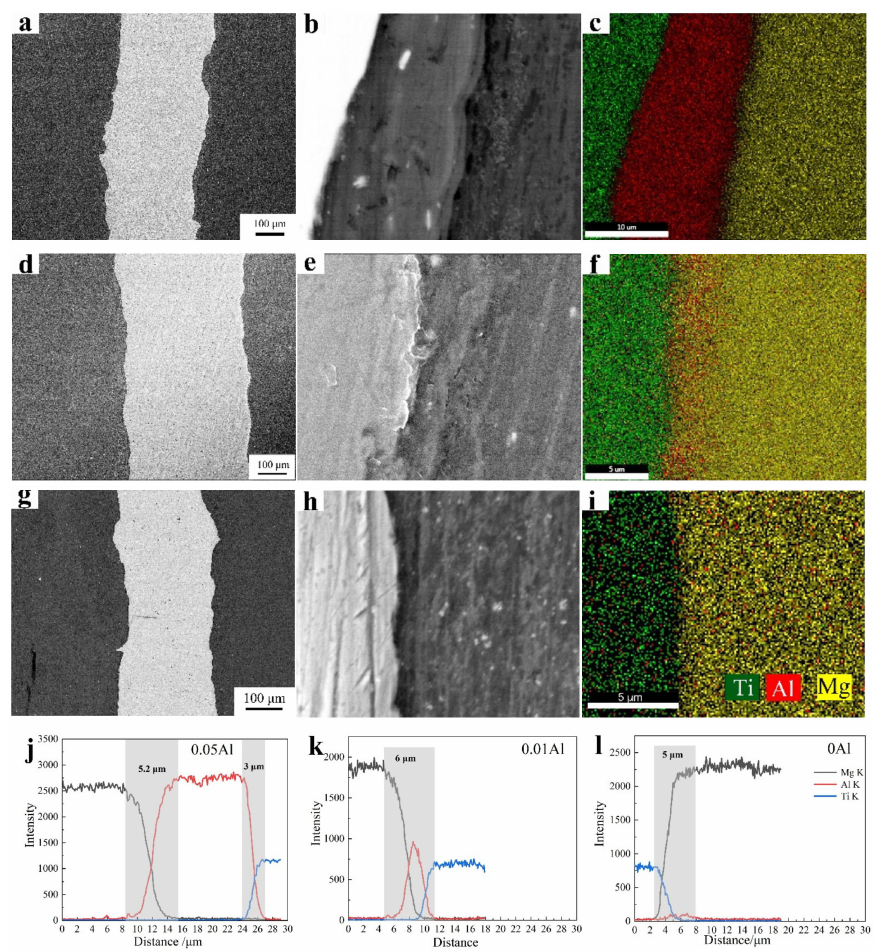
Figure 5. Microstructure and EDS scanning results of the interfaces for Mg-(Al-)Ti sheets with different Al layer thicknesses: ( a – c ) 0.05 mm Al layer, ( d – f ) 0.01 mm Al layer, and ( g – i ) Al layer without interdiffusion. ( j - l ) EDS line scanning of Mg-(Al-)Ti sheet rolled with different thicknesses of Al layer: ( j ) 0.05 mm, ( k ) 0.01 mm, and ( l ) for 0